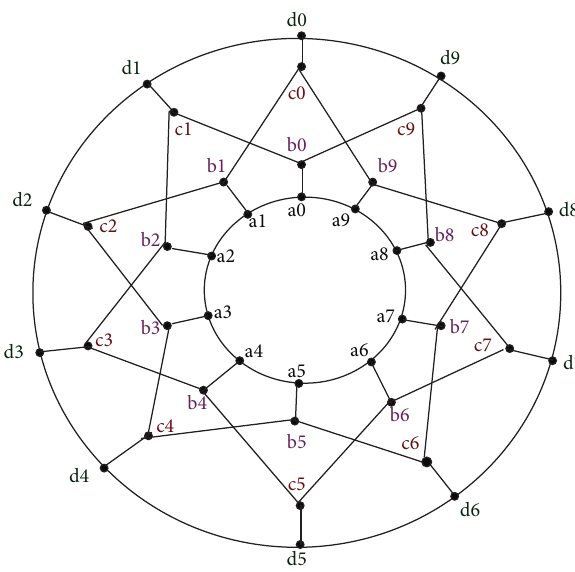
Figure 3: Generalized double Petersen graph DP ( 10 , 1 )